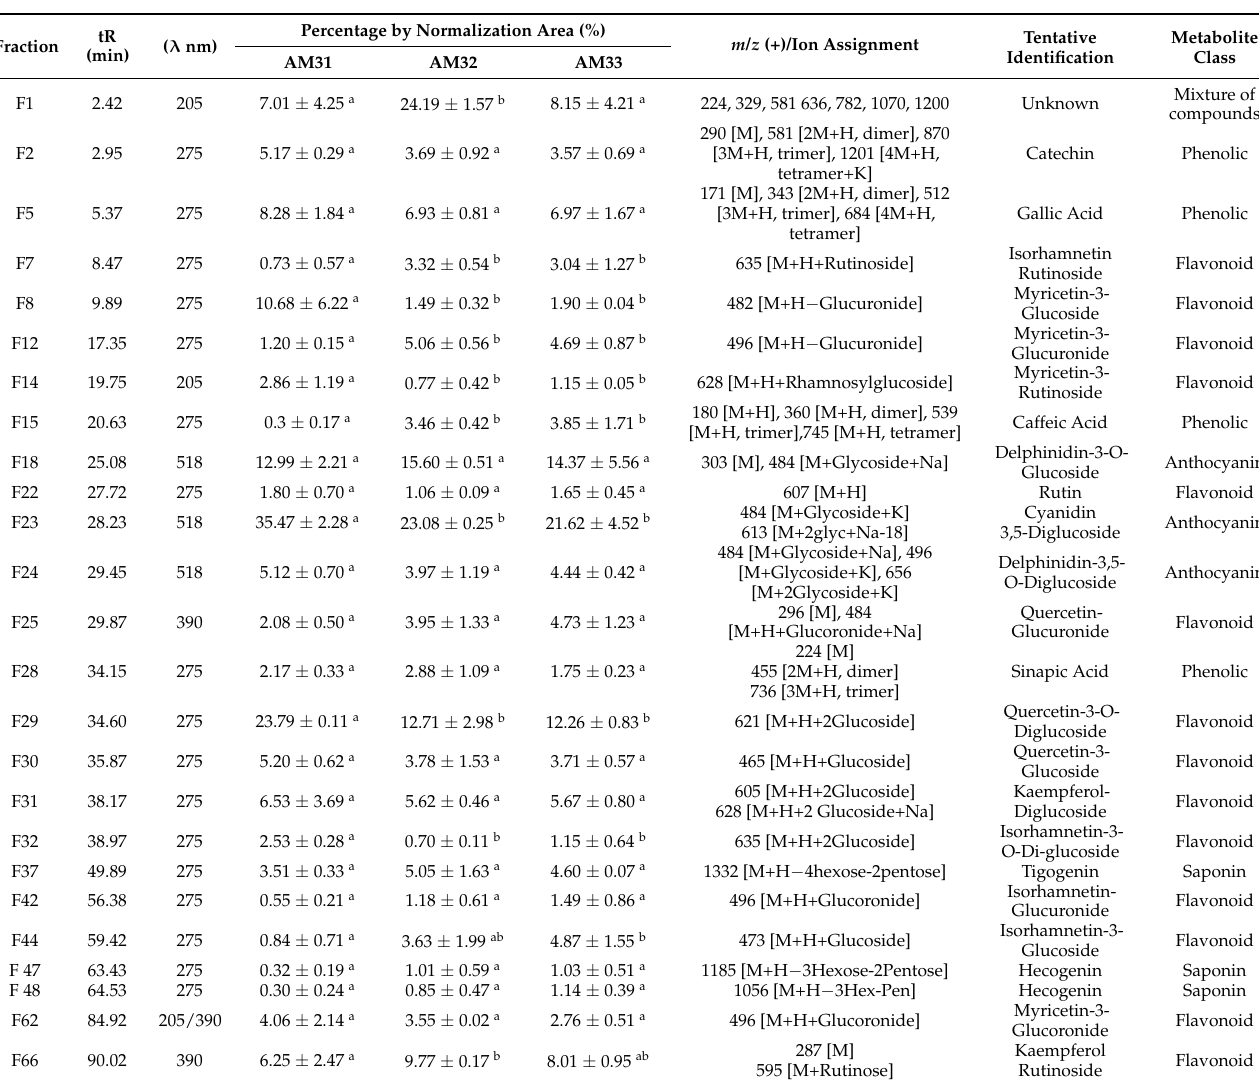
Table 4. Retention times (tR), wavelength ( λ nm), normalization area percentage (%) and [M+X] + and ion fragments ( m / z ) of collected fractions of hydroalcoholic crude extracts of A. marmorata shoots using HPLC-UV and MALDI-TOF